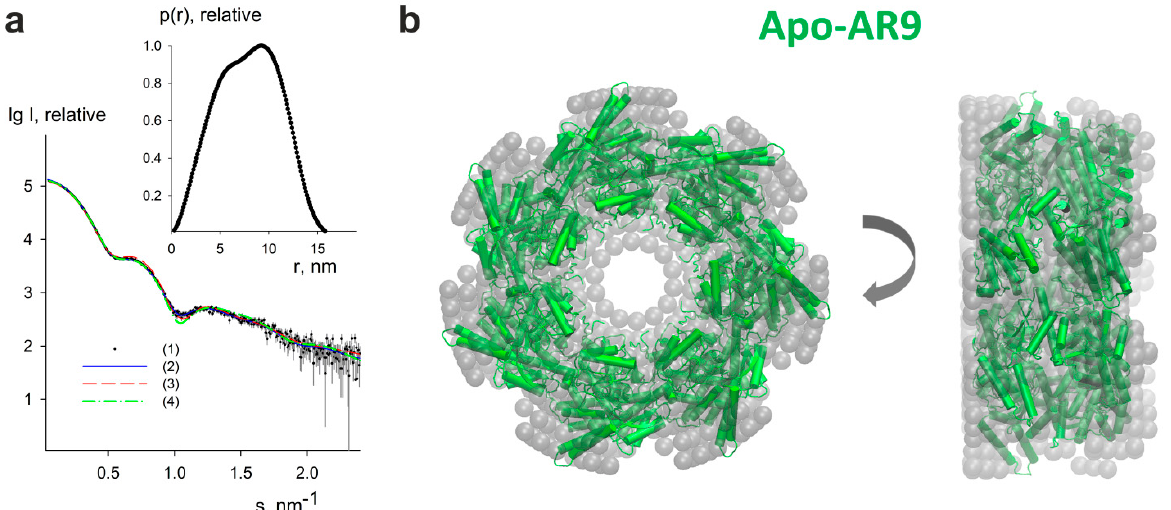
Figure 6. SAXS study of Apo-AR9. ( a ) Small-angle X-ray scattering patterns from Apo-AR9 chaperonin. Curve (1)—experimental data are displayed as dots with error bars, curve (2)—the fit from ab initio model obtained by DAMMIN [32] is shown as a blue solid line, curves (3) and (4)—theoretical scattering curves calculated by CRYSOL [33] from cryo-EM models with C1 and C7 symmetry are shown as red dashed and green dashed-dotted lines, respectively. The plots display the logarithm of the scattering intensity as a function of the momentum transfer. The inset displays the distance distribution function estimated by GNOM [31]. ( b ) Ab initio bead model of Apo-AR9 chaperonin obtained by DAMMIN (gray semitransparent spheres) overlapped with the heptameric cryo-EM model in the cartoon representation (green color). The right view was obtained by a 90° clockwise rotation around the vertical axis. The figure was generated using the VMD program [37].